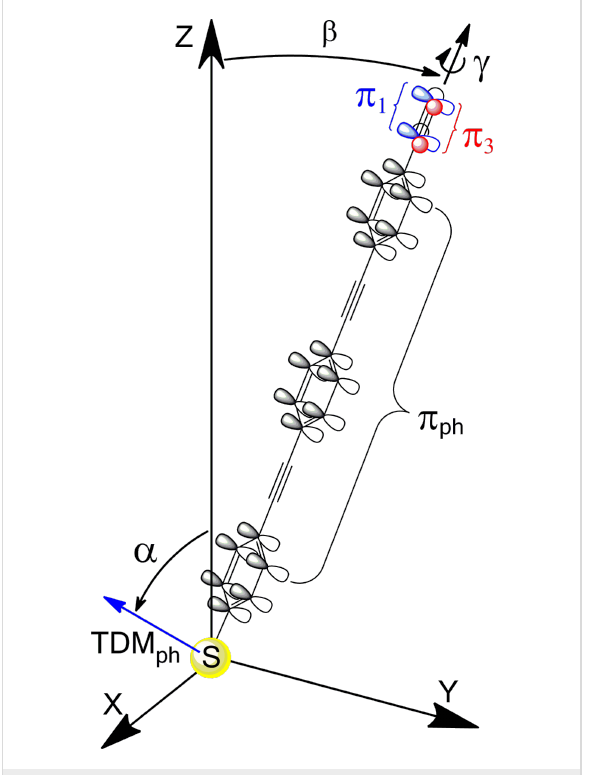
Figure 6: Orientation of the NC-OPE n molecules in the respective SAMs (by the example of NC-OPE3; a planar conformation is assumed). The orientation of the molecular backbone is given by the tilt angle β (tilt within the z–y plane) and twist angle γ . The π * orbitals of the phenyl rings ( π ph *), constituting the backbone, are perpendic- ular to the ring plane, with the orientation of TDM ph (blue arrow) given by the tilt angle α . π 1 * (blue) and π 3 * (red) orbitals of the nitrile group are perpendicular and parallel to the plane of the adjacent phenyl ring, respectively.